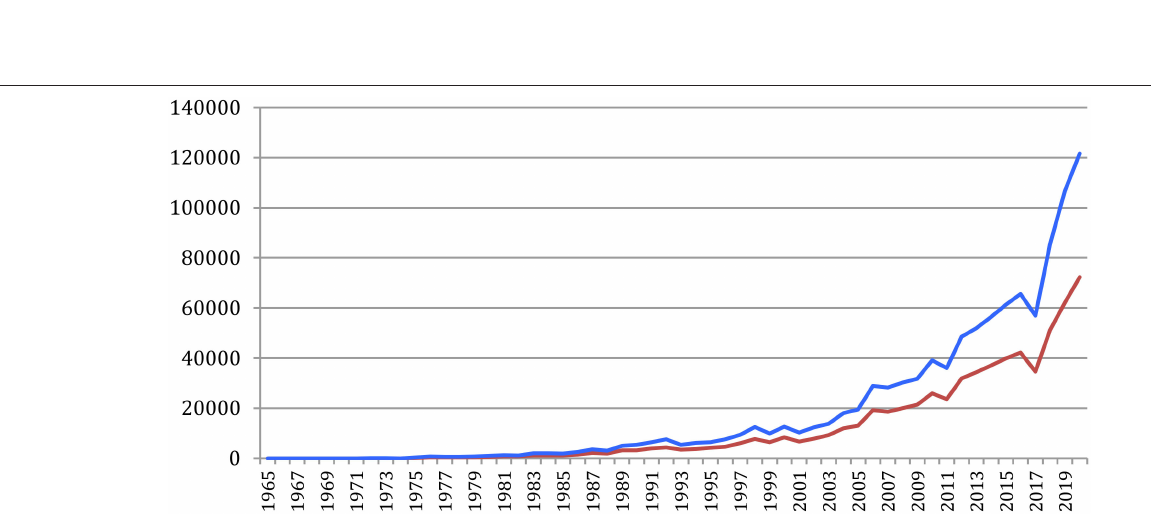
Frontiers in Research Metrics and Analytics | www.frontiersin.org